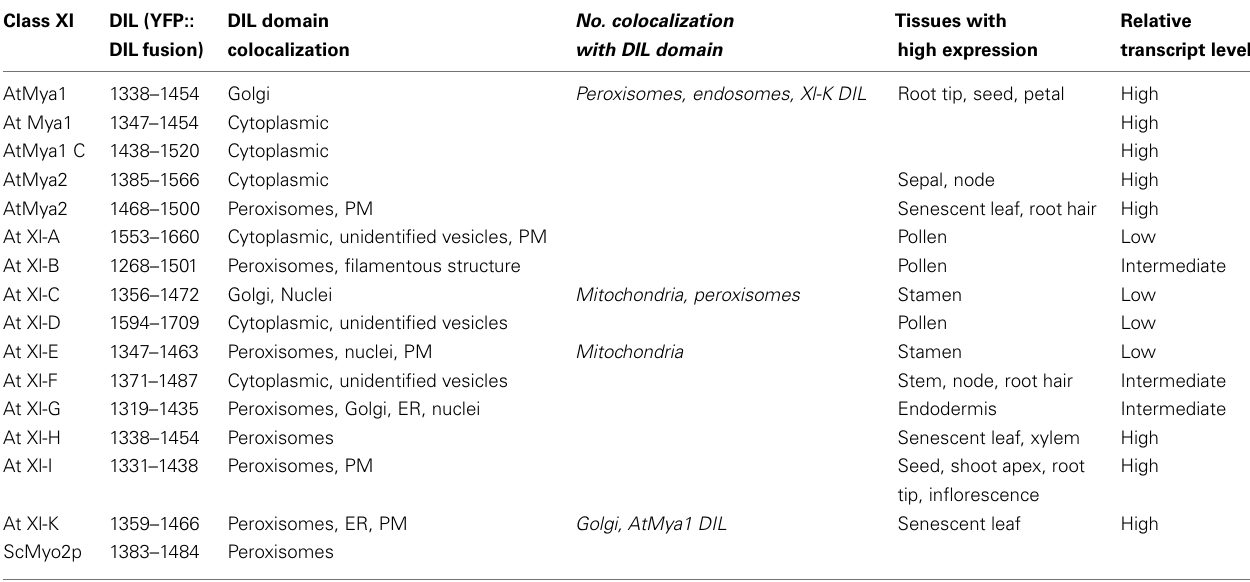
Table 1 | Summary of localization of DIL domains of A. thaliana class XI myosins N-terminally fused toYFP and transiently expressed in leaves epidermal cells of N. benthamiana